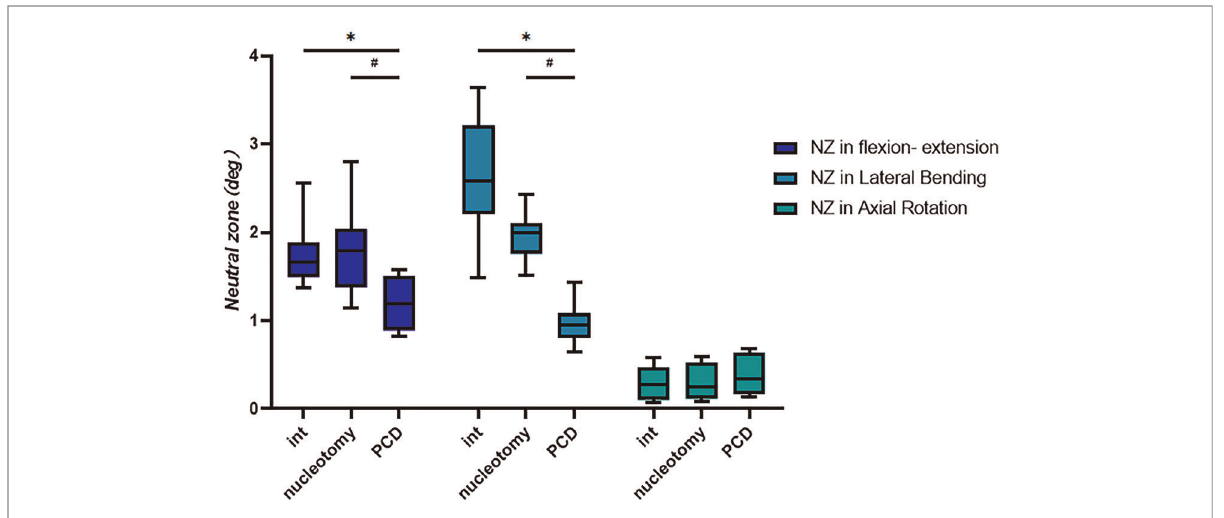
FIGURE 6 Neutral zones in different conditions. (n=8, ±SD, degree, °). * P <0.05: compared with the Int group; # P <0.05: compared with the nucleotomy group.